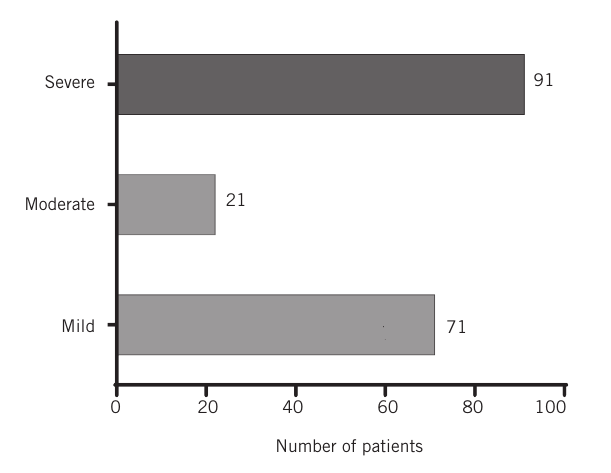
figurE 1 − Distribution of the three levels of severity of hemophilia A